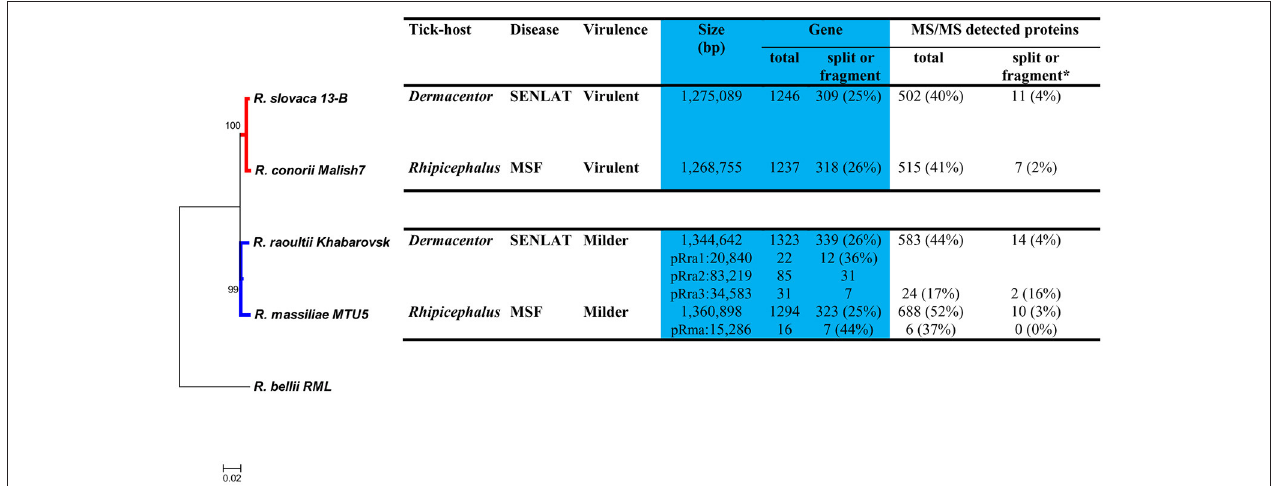
FIGURE 1 | Phylogenomic tree and, biologic, pathogenic, genomic, and proteomic features, of four SFG Rickettsia species. Bootstrap supports higher than 90% are shown at the nodes. *Means that the total of the detected MS/MS proteins corresponded to genes which are either split or fragment.